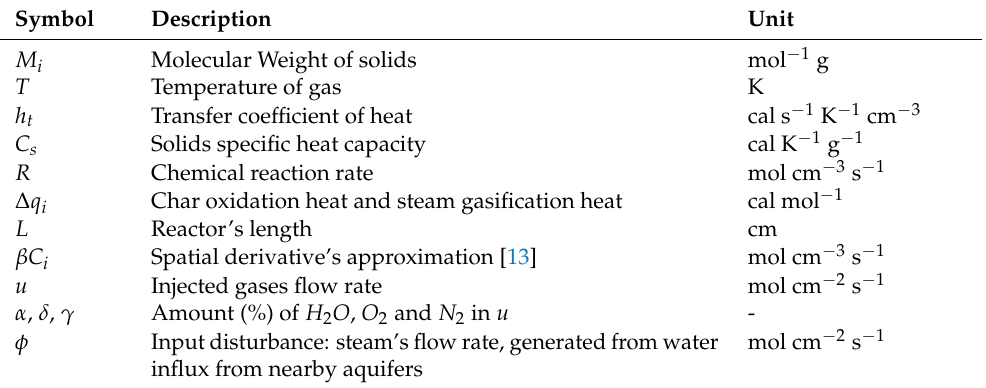
Table 1. Parameters and states.